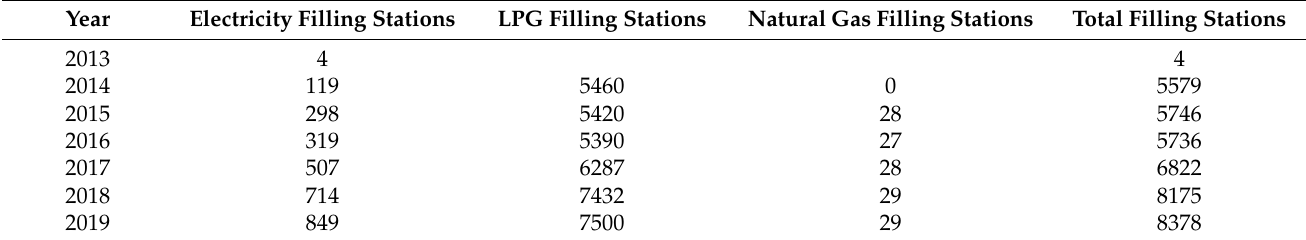
Table 4. Total number of infrastructure in 2013–2019